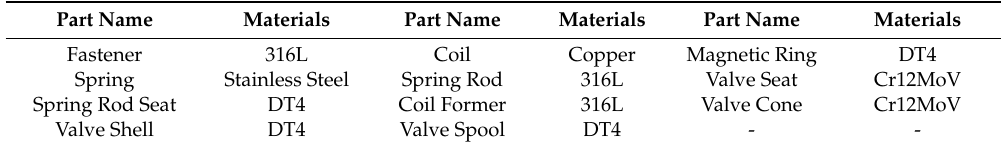
Figure 1. Structure diagram of the micro digital valve.